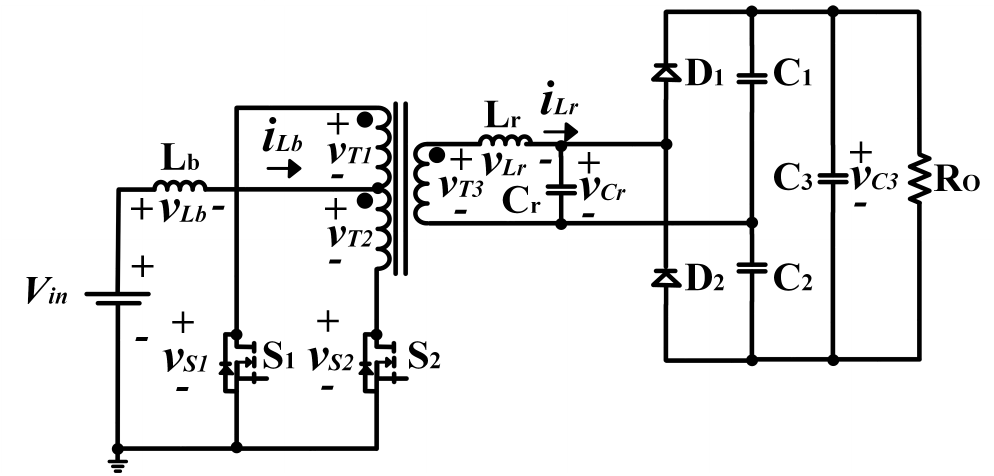
Figure 9. Push–pull converter.